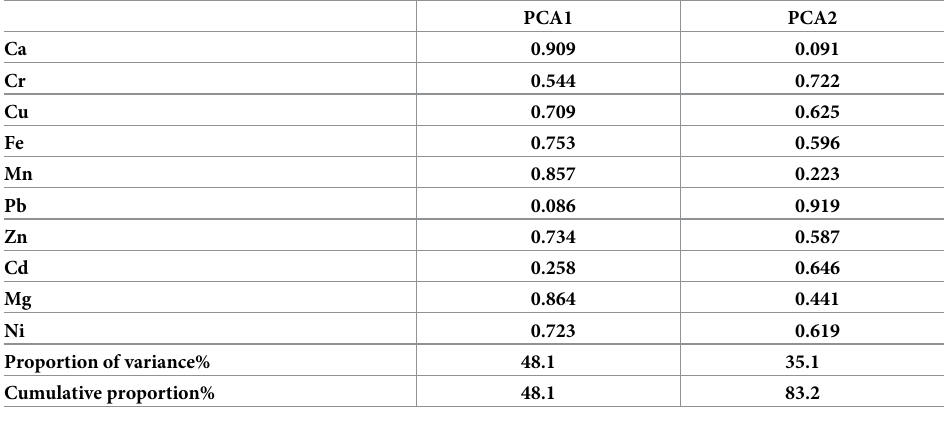
Table 5. Summary of principal component analysis